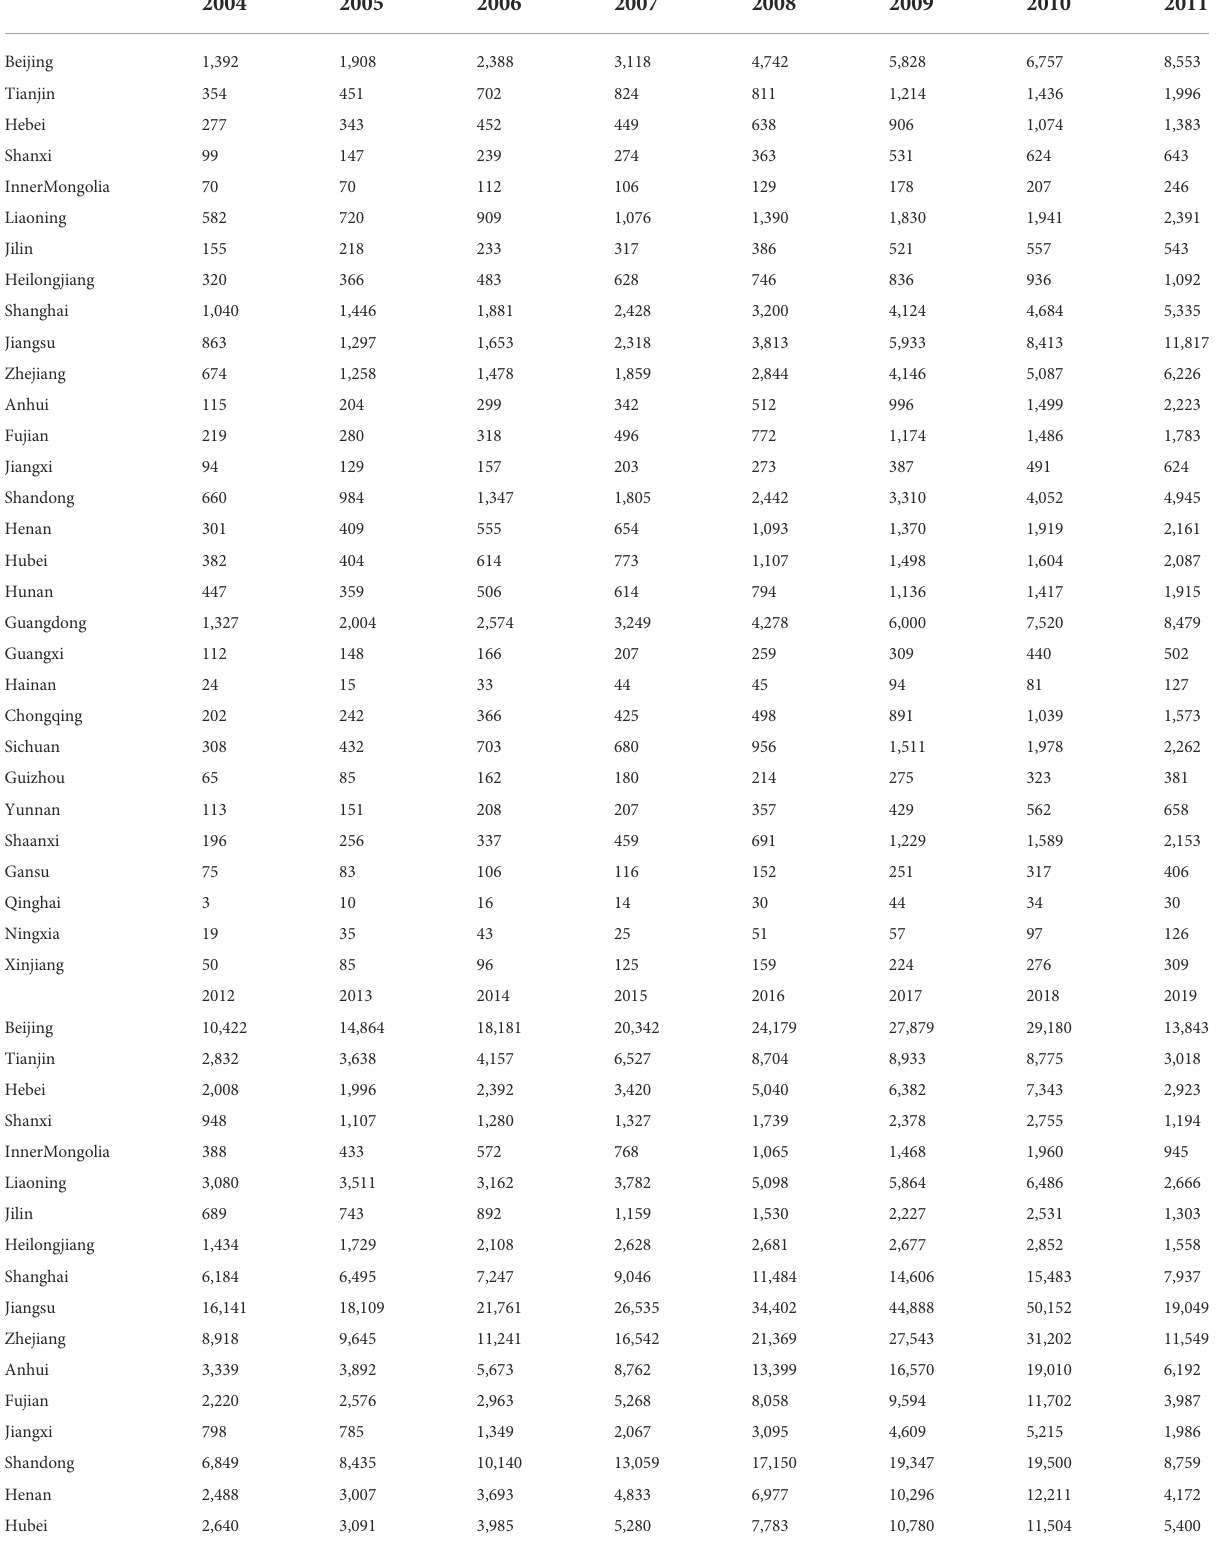
TABLE A1 Number of green patent applications from 2004 to